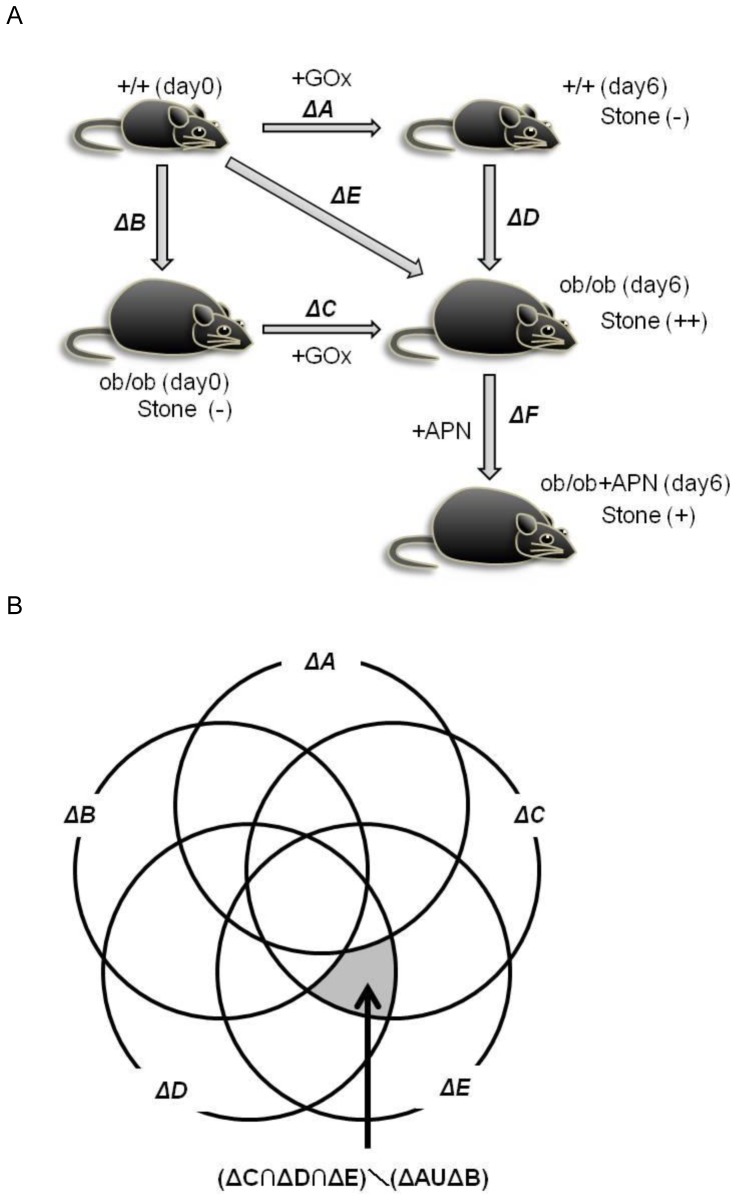
The scheme of the microarray analysis design.A. Experimental design and gene expression changes between groups. Δ refers to a gene group with >2.0- or <0.5-fold expression change between 2 experimental groups. ΔA means gene expression involving GOx administration. ΔB means gene expression involving obesity. ΔC means gene expression involving GOx administration and kidney stone formation. ΔD means gene expression involving obesity and kidney stone formation. ΔE means gene expression involving obesity, GOx administration, and kidney stone formation. ΔF means gene expression involving APN administration and kidney stone prevention. +GOx, glyoxylate administration; +APN, adiponectin treatment. B. The selection scheme for kidney stone formation-related gene groups (Venn diagram). The gray-stained area is represented by (ΔC∩ΔD∩ΔE)\(ΔA∪ΔB) and is the kidney stone formation-specific gene group under a MetS environment.